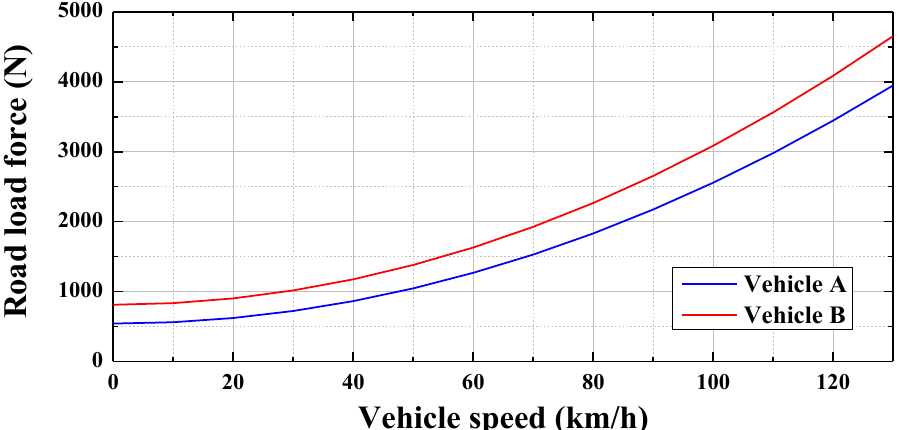
Figure 6. Example of predicted coastdown results represented by a three-term polynomial